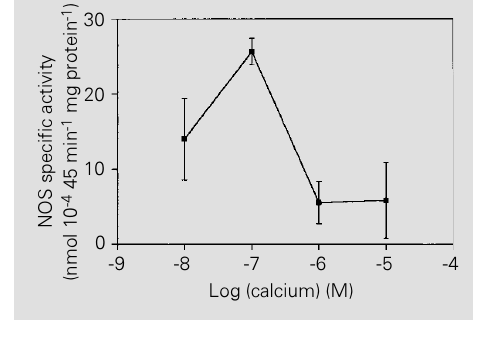
Figure 3 - Langerhans islet spe- cific NOS activity from control rats measured at different sub- strate concentrations.